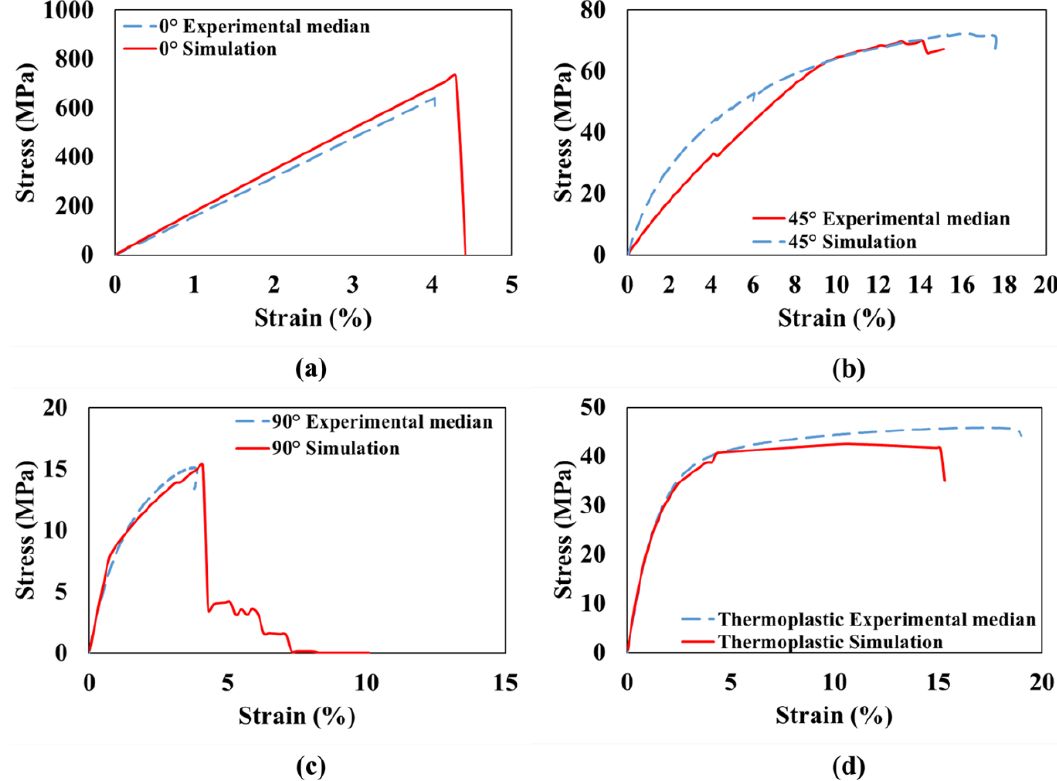
Figure 8. Comparison of stress-strain curves from the experiment and simulation for single-angled 3D-printed GFRP composite with ( a ) ±0°, ( b ) ±45°, ( c ) ±90°, and ( d ) thermoplastic.